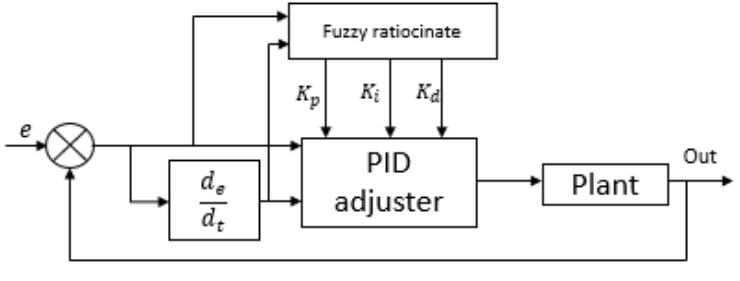
Figure 3. Basic model predictive scheme